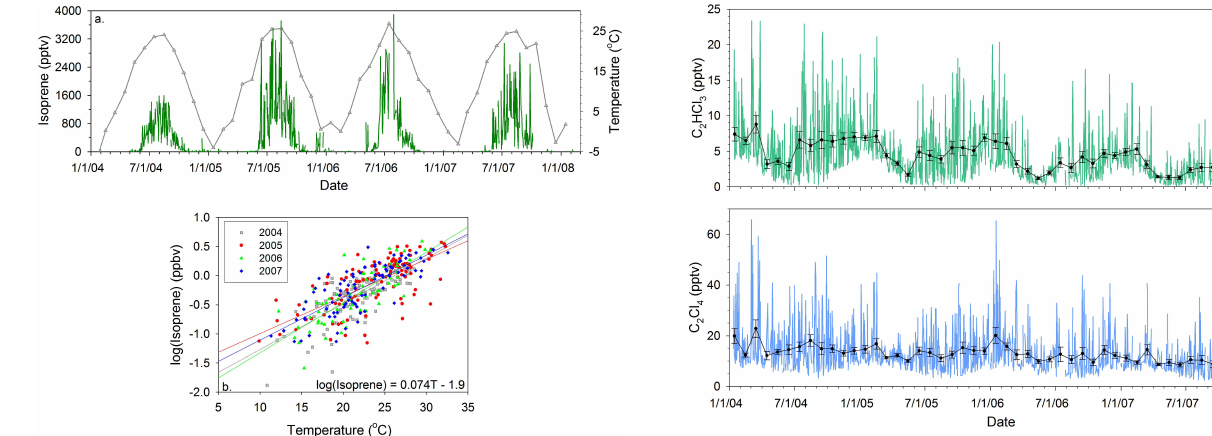
Fig. 4. (a) Time series of isoprene (pptv) (green line) and the monthly mean temperature ( ◦ C) (gray line) at TF during January 2004–February 2008. (b) Correlation between log(isoprene) (in ppbv) and the hourly average temperature (corresponding to the hour the canister sample was collected) during June–September of 2004, 2005, 2006, and 2007.